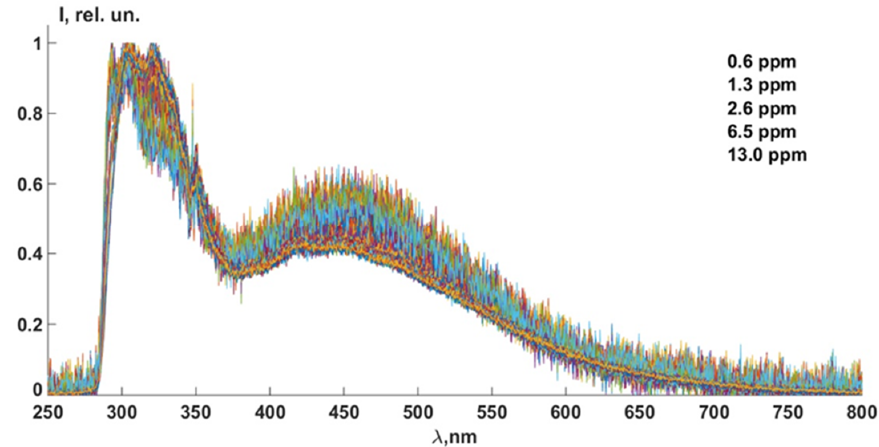
Figure 9. Sequences of the LIF spectra of the five concentrations of crude oil solutions.